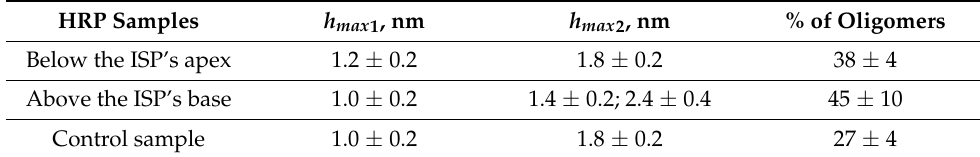
Table 1. Maximum heights of the ρ ( h ) curves and relative content of HRP aggregates after adsorption on